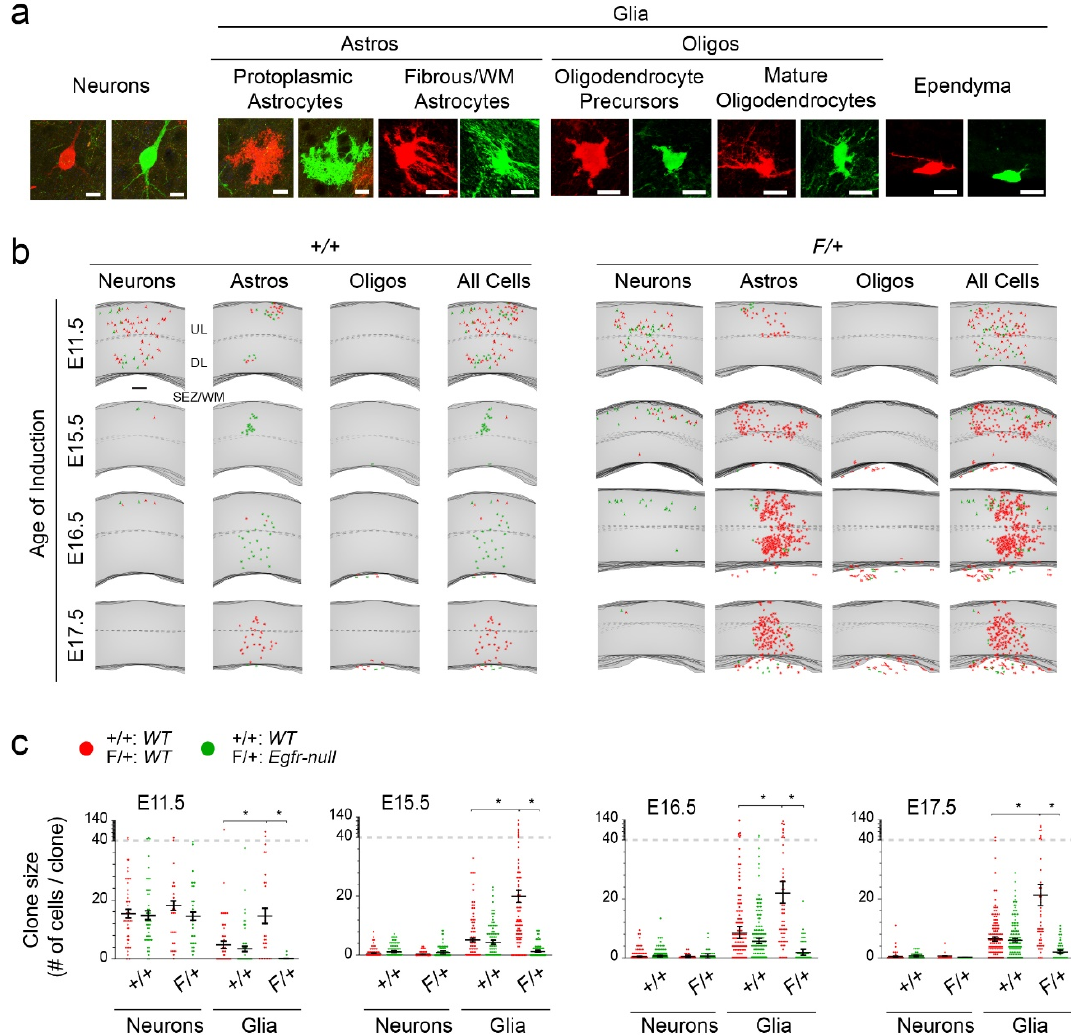
Figure 2. Glial subtypes in MADM clones. ( a ) Samples representing classified cell types in both red and green MADM cells. Scale bars, 10 μ m. ( b ) Maps of cell type distributions in the cortex of +/+ and F/+ mice at different induction time points. Scale bars, 100 μ m. ( c ) Plots of clone sizes (number of total cells) in the green and red clonal populations in the cortex at P30 under various induction time points. Each dot represents individual clones and averages are depicted ± sem. *, Student’s t-test, p < 0.05.